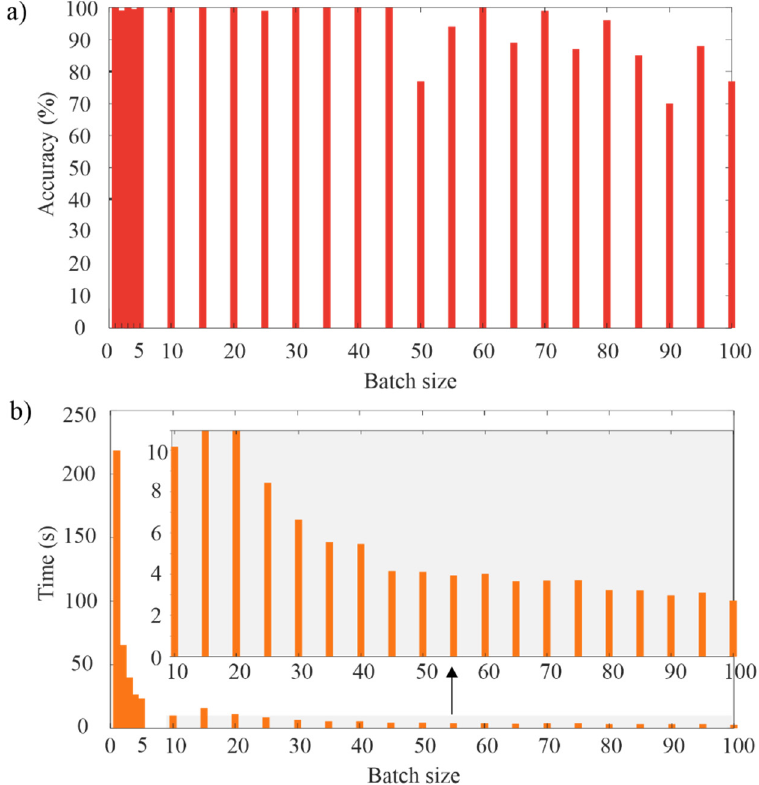
Figure 15. Results for different batch size values: ( a ) accuracy; and ( b ) computational time.